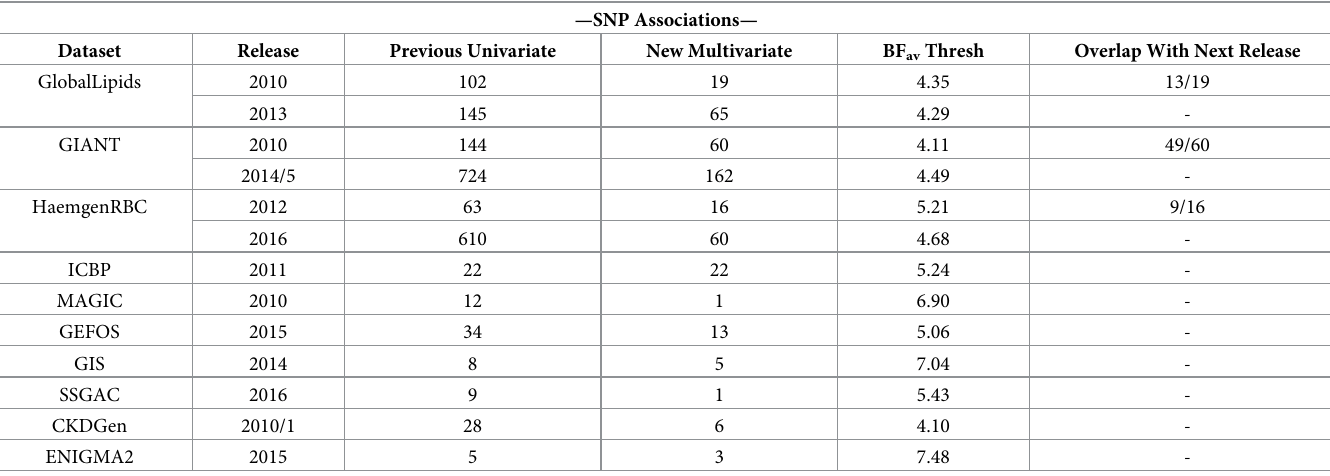
Table 2. Summary of new multivariate associations identified.